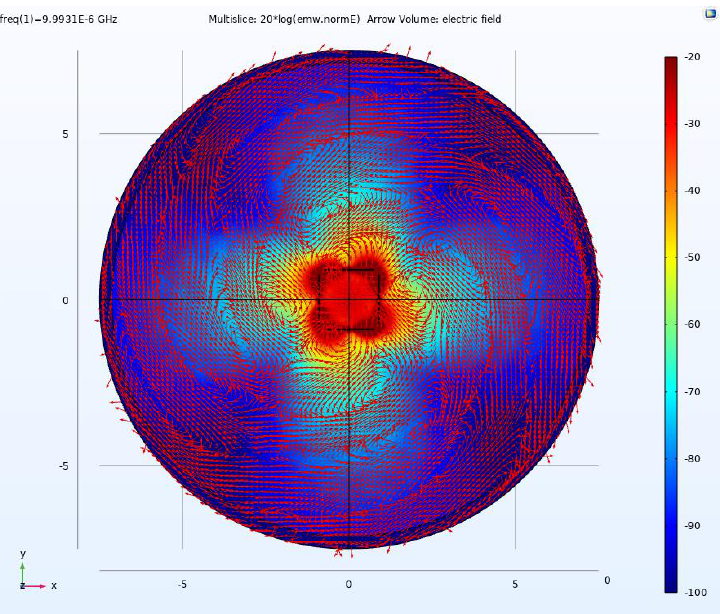
Figure 8. Electric field distribution and direction on MD plane.